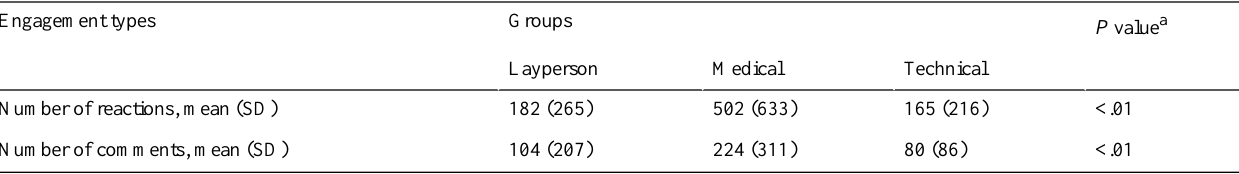
Table 5. Member engagement in layperson, medical, and technical